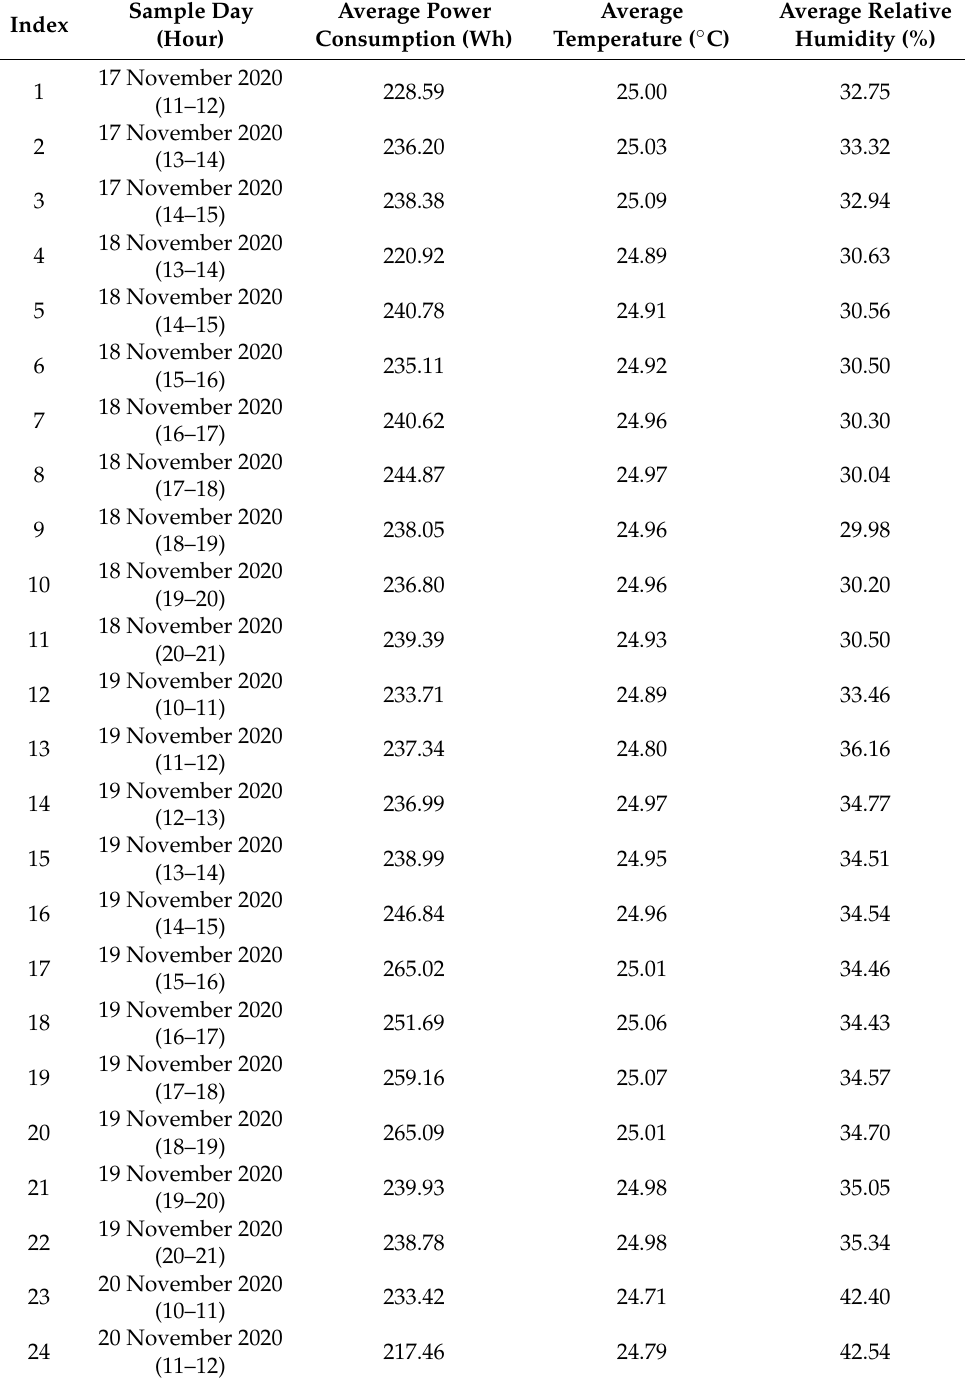
Table 5. Power consumption, temperature, and humidity of the HVAC equipment with the built-in control